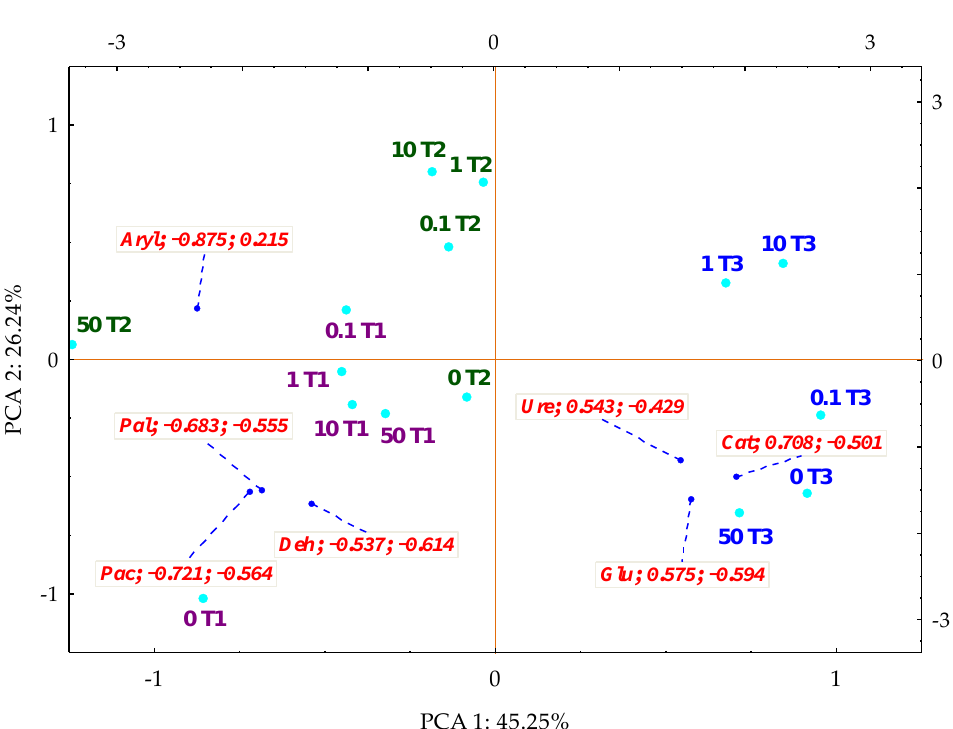
Figure 13. Coefficients of impact (IF Pc ) of Perna canaliculus for the enzyme activity in soil contami- nation with o -cresol—PCA method. The end of the vector of the primary variable: Deh—dehydro-